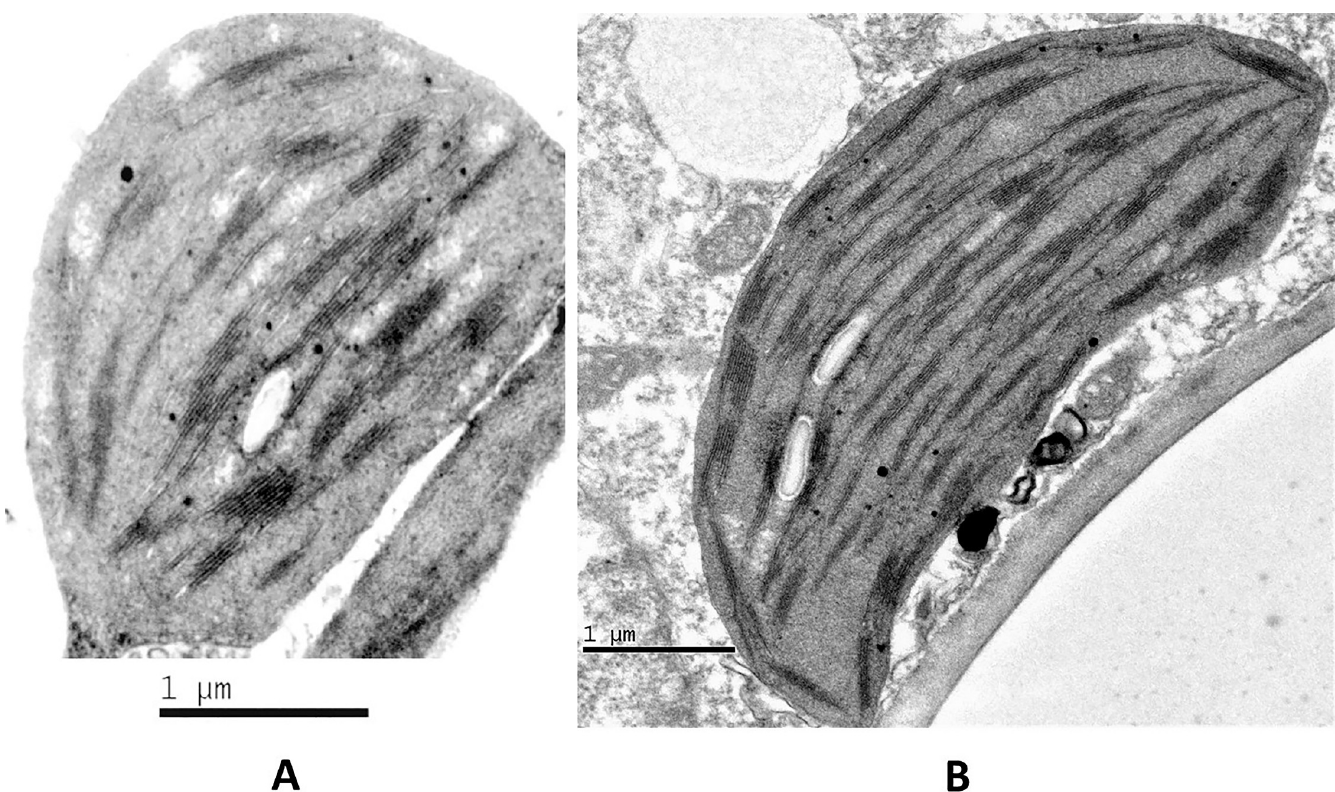
Fig 2. Transmission electron micrograph of chloroplast in Scots pine. (A) Formation of thylakoids in under DARK (B) Developed chloroplast under SUN.